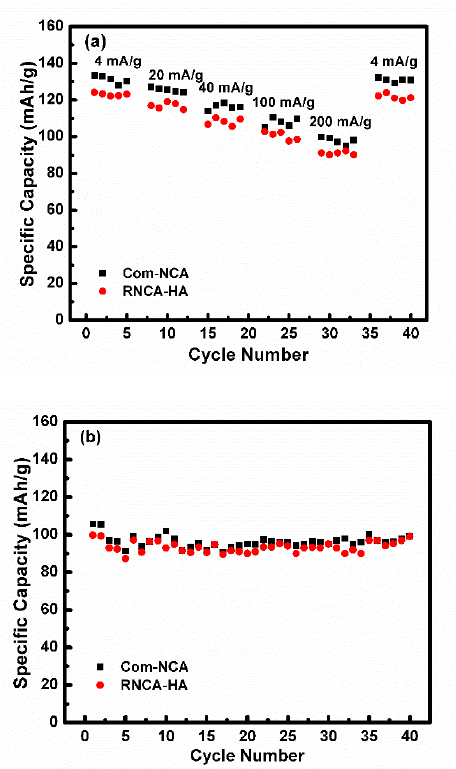
Figure 12. Performance test of RNCA ‐ HA: ( a ) Ratability; ( b ) Cyclability at 100 mA/g.